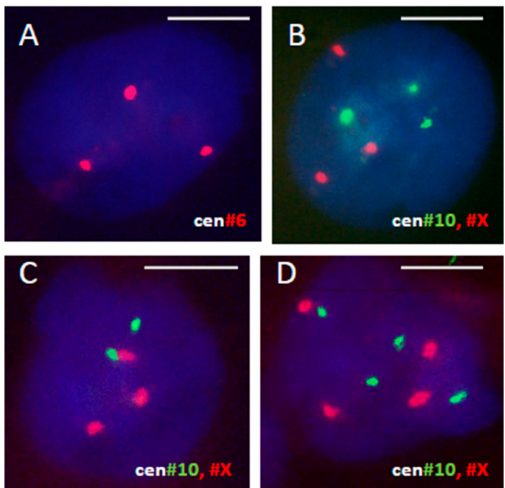
Figure 2. Representative fluorescent in situ hybridization (FISH) patterns revealing ( A , B ) triploid, ( C ) diploid, and ( D ) tetraploid cell nuclei 48 h after 10 Gy hit in HeLa cells using centromeric labels for three chromosomes, #6, 10, X.